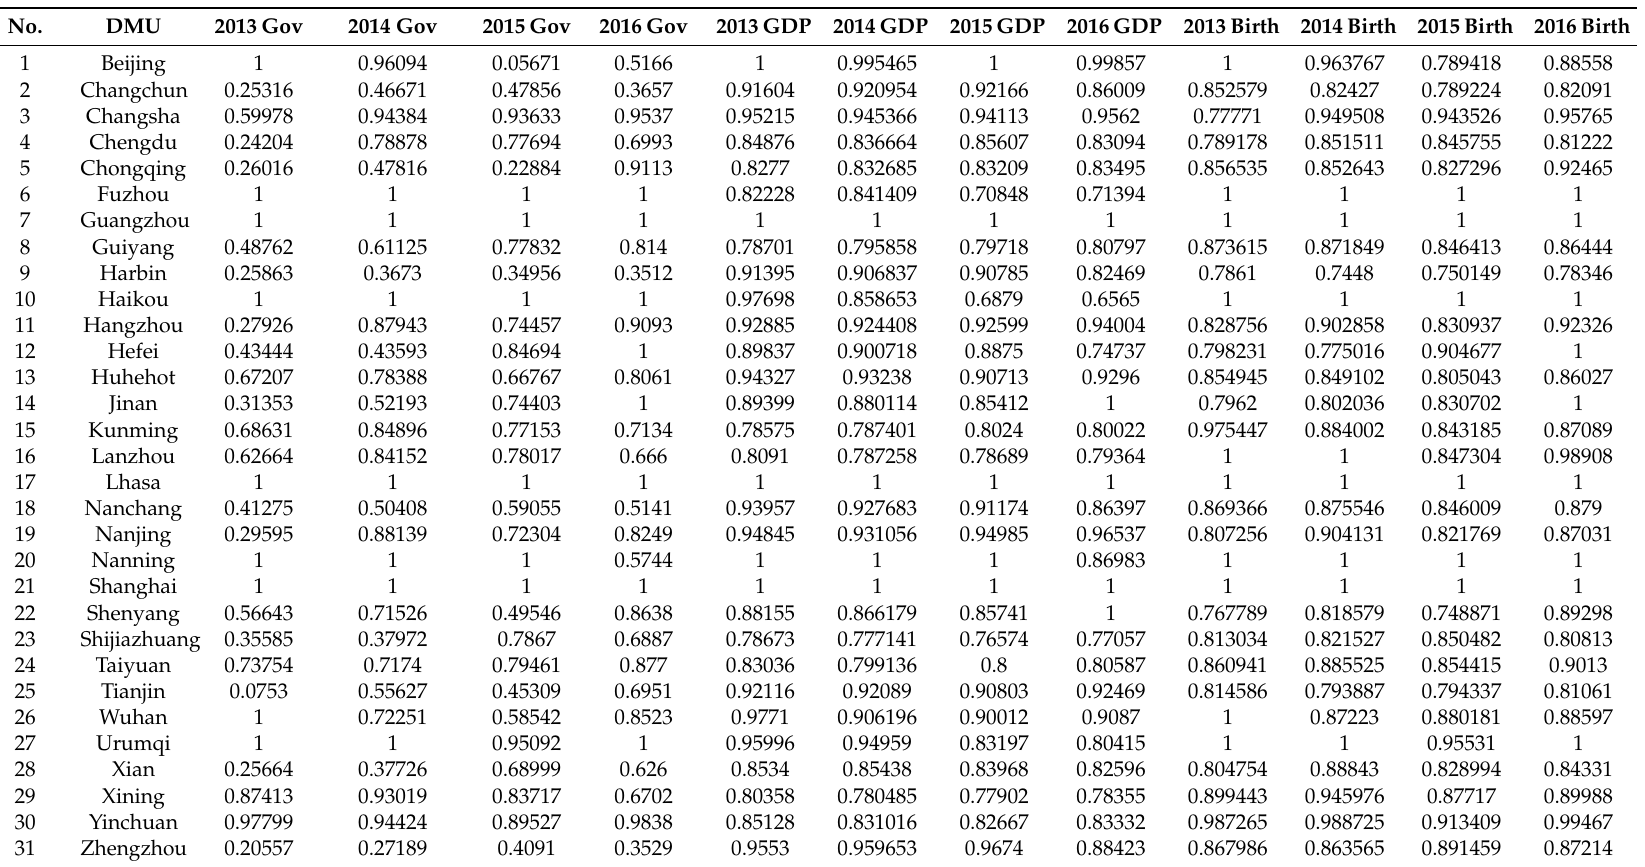
Table 5. Health expenditure, GDP, and birth